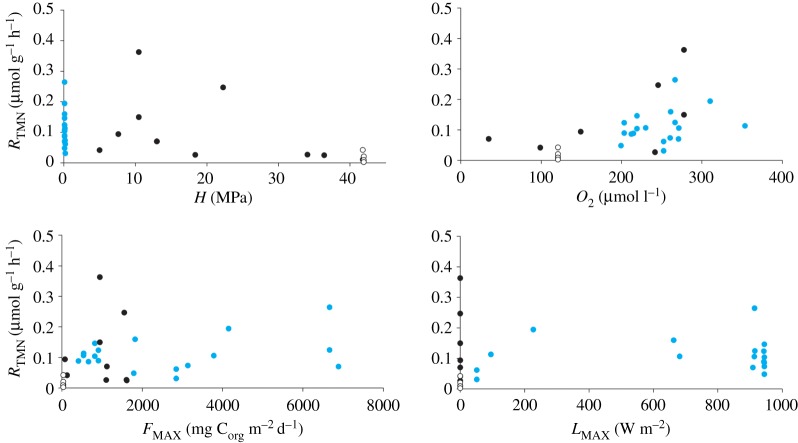
Temperature- and mass-normalized holothurian metabolic rate (RTMN) as a function of in situ hydrostatic pressure (H), oxygen concentration (O2), food availability (FMAX) or light availability (LMAX). Metabolic rate data were normalized to a temperature of 2.5°C using a shallow-water-holothurian-derived Q10 of 2.12, and to a standard total wet mass (M) of 70 g using a shallow-water-holothurian-derived mass-scaling coefficient of 0.5858. Blue circles represent shallow-water data (from [13,28–41]), black circles represent deep-sea data (from [10,13,56–59]) and open circles represent data from this study.